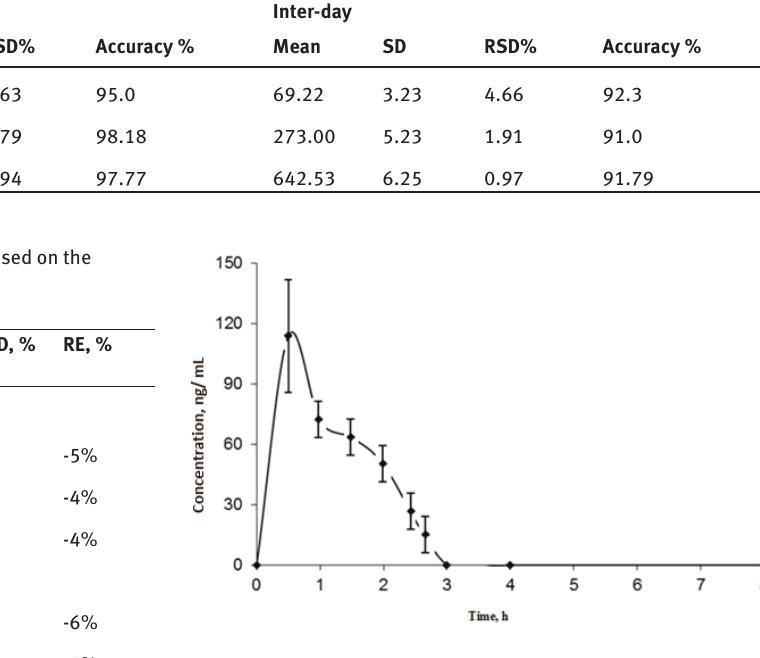
Figure 4: Concentration-time curve of lixivaptan in mouse plasma after oral administration of 10 mg kg -1 lixivaptan. Each point represents mean value ±